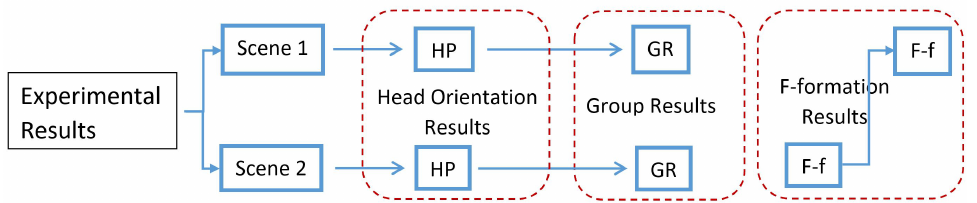
Figure 15. We organise the presentation of the results according to three main headings: head orientation, group detection, and estimating F-formation. In head orientation and group detection,